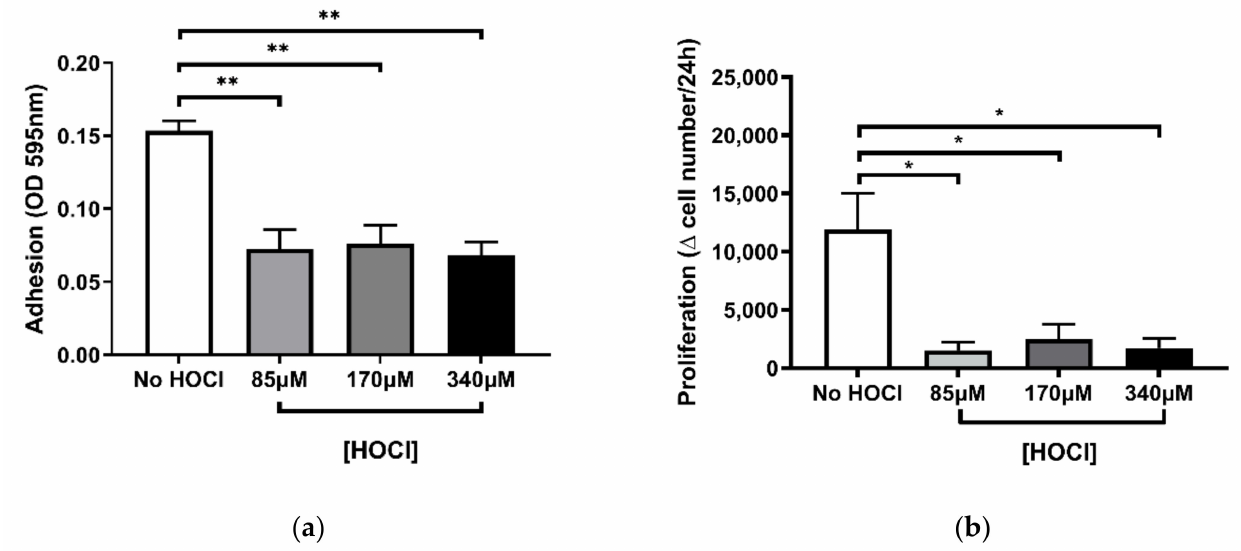
Figure 2. Cell-derived ECM oxidised by HOCl reduces the capacity of fibroblasts to adhere and proliferate. BEAS-2B-derived ECM was oxidised with (or without) HOCl concentrations of 85 µ M, 170 µ M, and 340 µ M for 30 min, then washed and seeded with PHLF at 1 × 10 5 cells/mL in 0.1% FBS DMEM for 2 h. Attachment was assessed by Coomassie brilliant blue staining ( a ) and 6.0 × 10 4 cells/mL in 5% FBS DMEM for 96 h, while proliferation was measured by manual cell counts ( b ). n = 5. ** p < 0.01, * p < 0.05, significance was compared against No HOCl control; one-way ANOVA with Dunnett’s multiple comparison test was